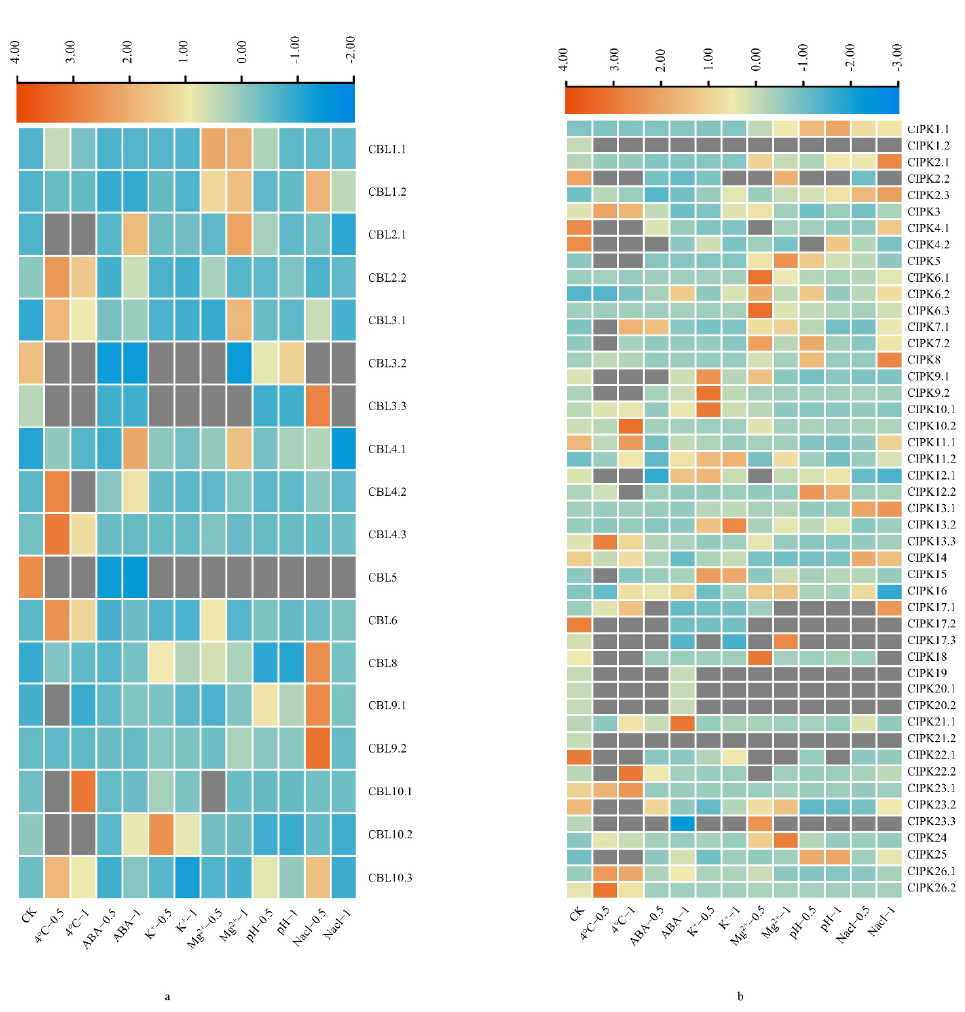
Figure 6. Expression profiles of BraCBL and BraCIPK genes in different stress treatments. ( a ) Ex- pression analysis of BraCBLs in six different treatments at 0.5 h and 1 h. ( b ) Expression analysis of BraCIPKs in six different treatments at 0.5 h and 1 h.